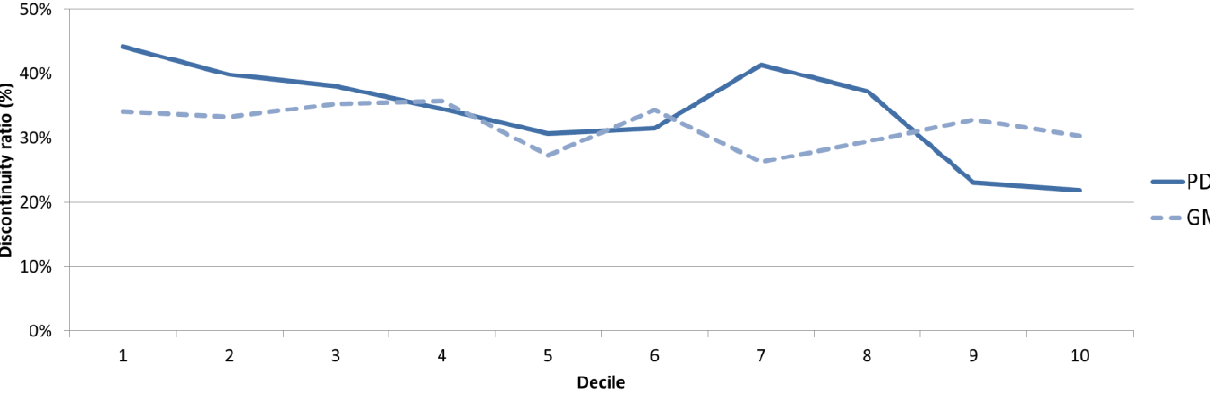
Figure 10. Discontinuity ratio of problem and solution space in the PDE vs.